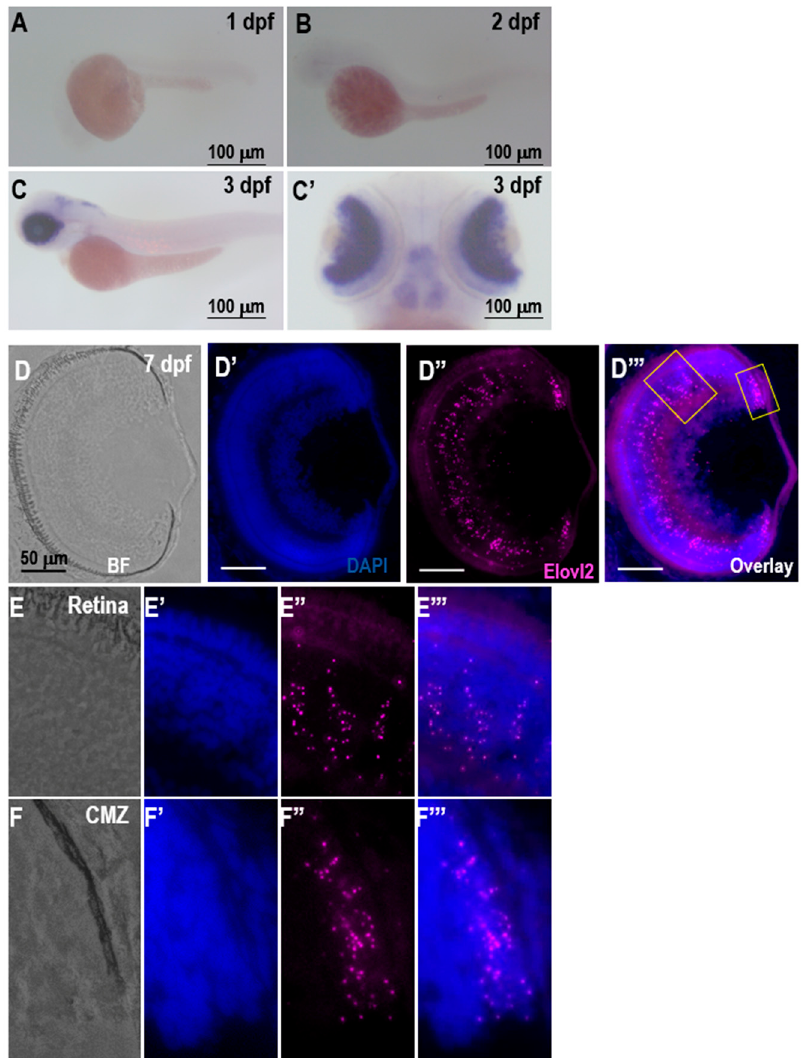
Figure 1. A–C, expression of elovl2 in zebrafish larvae. Lateral view of elovl2 staining in ( A ) 1 dpf and ( B ) 2 dpf zebrafish retinas. Lateral ( C ) and dorsal ( C’ ) view of elovl2 staining in 3 dpf zebrafish retina, respectively. D–F. RNAscope in situ hybridization with elovl2 probe in 7 dpf zebrafish retina showing brightfield ( D – F ), 4 ′ ,6-diamidino-2-phenylindole (DAPI staining ( D’ – F’ ), elovl2 ( D’’ – F’’ ) and overlay ( D’’’ – F’’’ ) images. Scale bars = 50 μ m. Magnified view (40x) of boxed regions in Figure 1D’’’. The magnified views of Retina (Panel E) and ciliary marginal zone (CMZ) (Panel F) showing elovl2 staining in 7 dpf zebrafish retina .